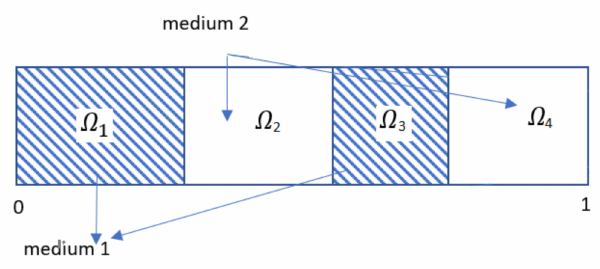
Figure 1. The unit